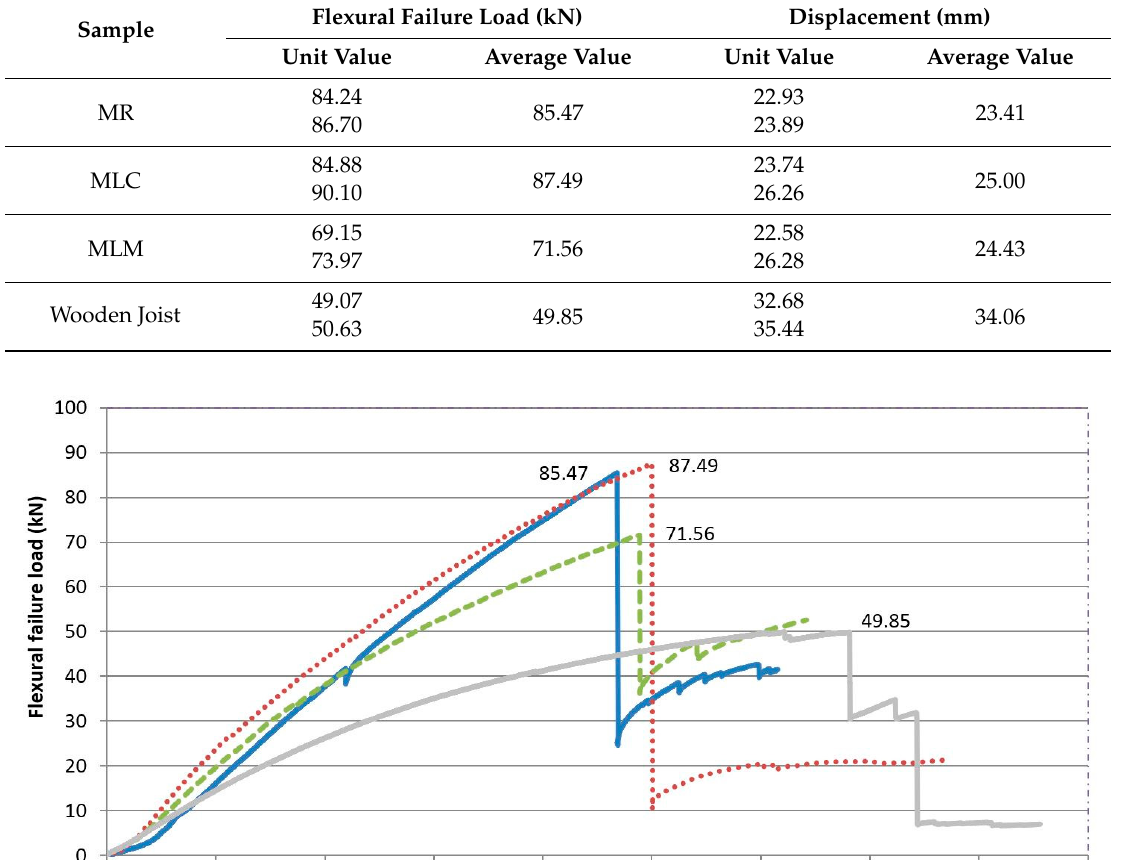
Figure 14. Full-scale test results.